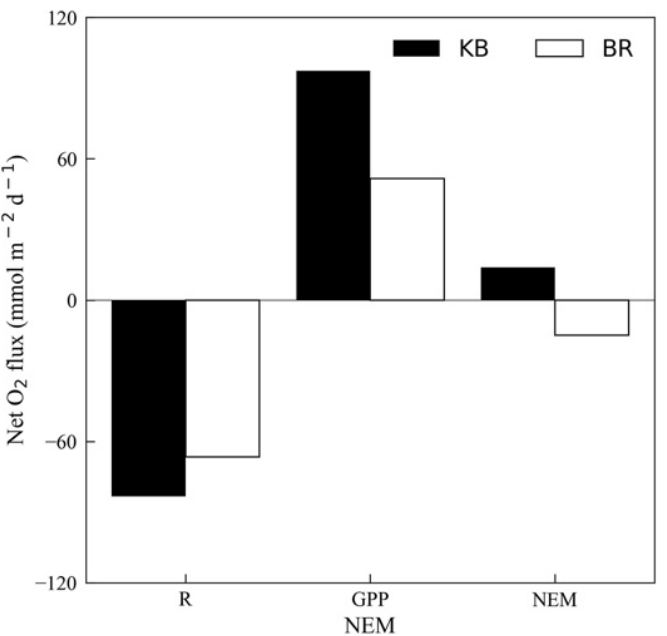
Figure 9. Comparison of net ecosystem metabolisms (R, GPP, and NEM) in KB and BR.